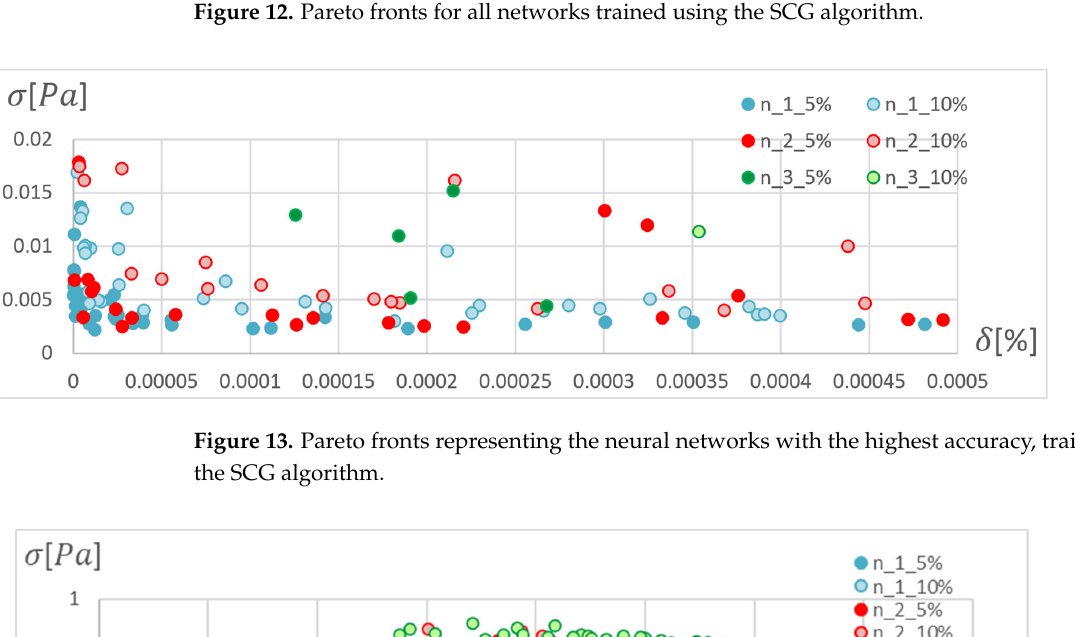
Figure 14. Pareto fronts presented on a logarithmic scale for all networks trained using the SCG algorithm.